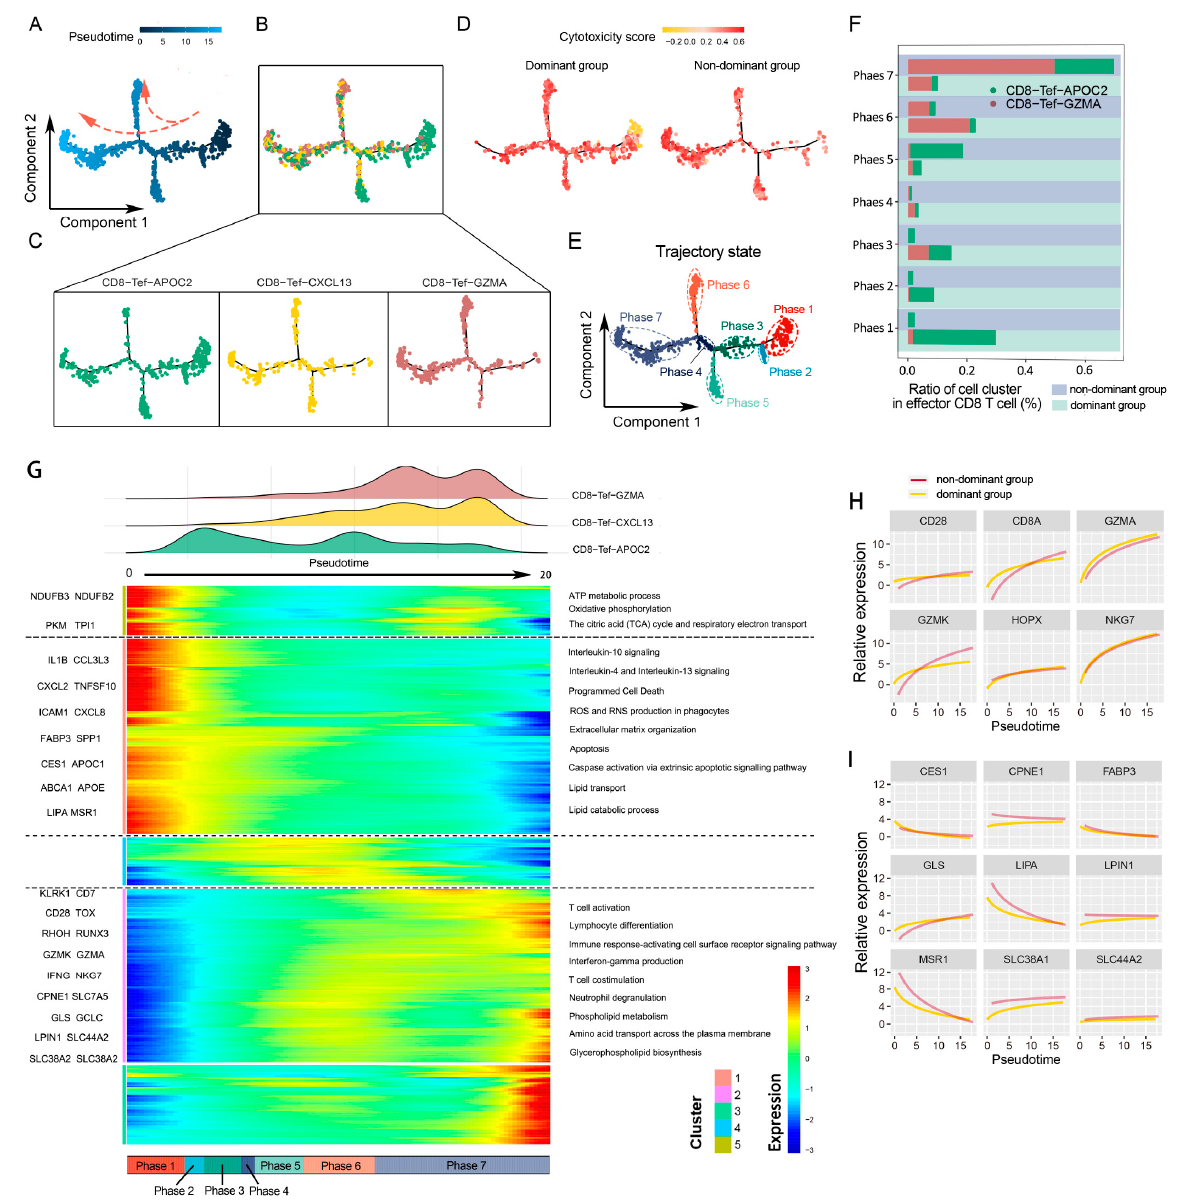
Figure 5. Differentiation directions of Tef subsets under different glutamine metabolic stress. ( A ) Pseudotime-ordered analysis of Tef cells. Arrows indicate direction of development. ( B , C ) Trajec- tory trees showing the distribution of Tef cell subtypes along the developmental trajectories. T cell subtypes are labeled by color: CD8-Tef-GZMA is colored with brown, CD8-Tef-CXCL13 with yellow, and CD8-Tef-APOC2 with green. ( D ) 2D pseudotime plot showing the dynamics of cytotoxic score of Tef cells in the dominant group and nondominant group. ( E ) 2D graph of pseudotime-ordered Tef cells. The trajectory state is labeled by color. ( F ) Histogram showing the cell distributions of CD8-Tef-GZMA and CD8-Tef-APOC2 over 7 phases between the dominant group and nondominant group. Tef subtypes are labeled by colors. ( G ) Heatmap showing the dynamic changes in gene expression along pseudotime. Representative genes of clusters 1, 2, and 5 are listed to the left of the heatmap. The DEGs of this heatmap are listed in Supplementary Table S8. Immune-regulation-related and metabolism-related pathways are marked to the right of the heatmap. Enriched pathways (GO and REACTOME) of the three clusters are listed in Supplementary Table S9. ( H , I ) Two-dimensional plots showing the dynamic expressions of metabolism-associated genes ( I ) and immune-associated genes ( H ) during Tef cell transitions along pseudotime.